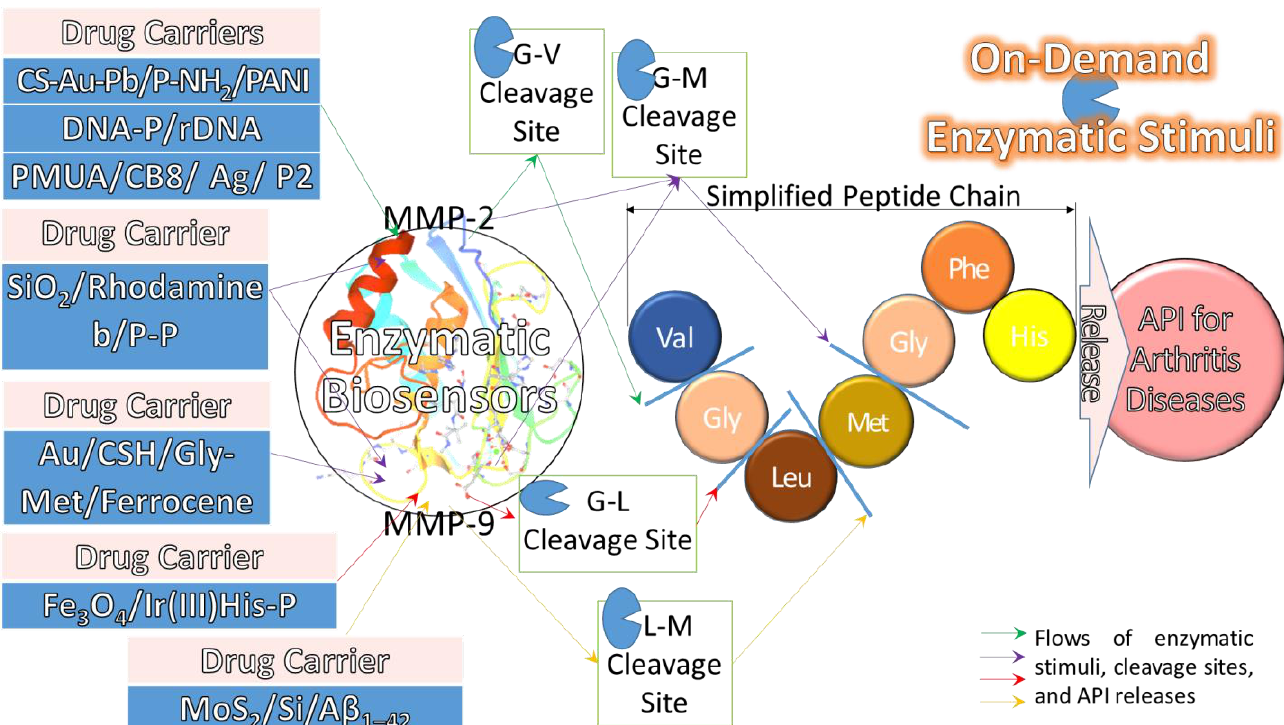
Figure 7. The enzymatic stimulation mechanisms of biosensors in drug carrier use MMP-2 and MMP-9 [158,167] to cleave peptide sites for API release in arthritis treatment. Reprinted with per- mission.